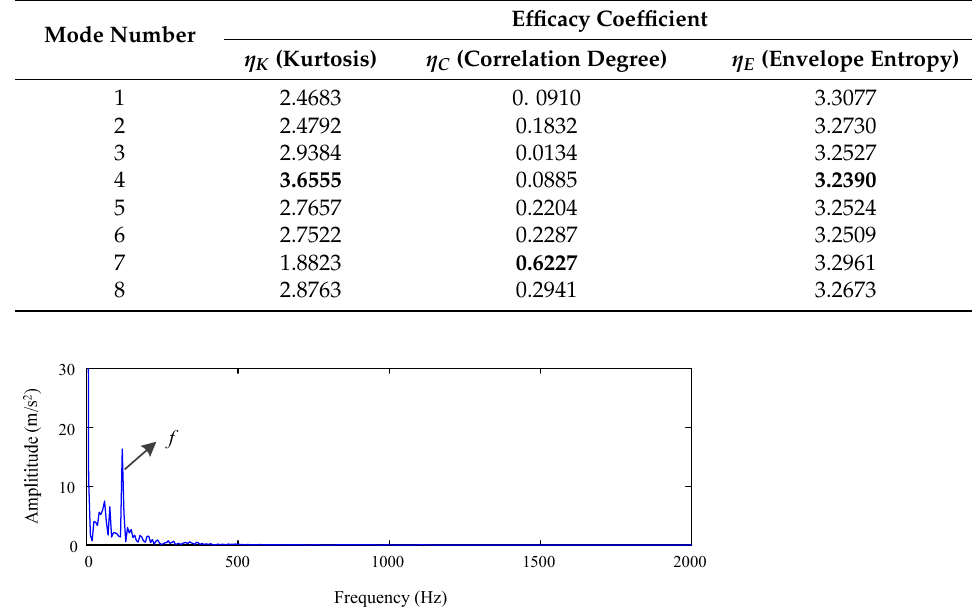
Figure 35. Envelope spectrum of optimal component of challenging signal by using IVMD.